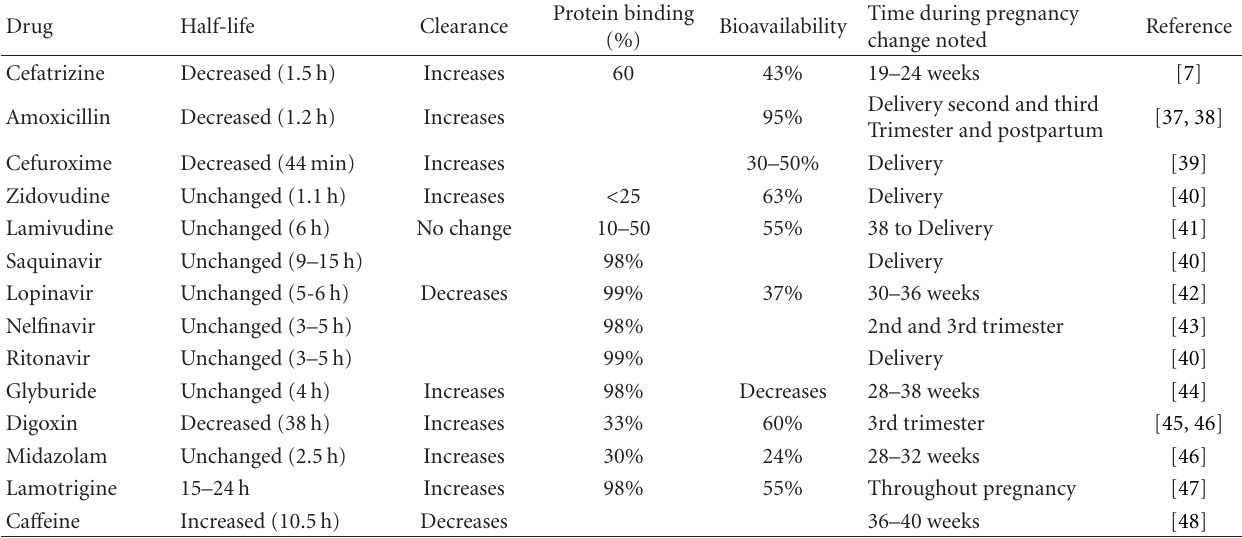
Table 2: Pregnancy-induced pharmacokinetic changes for selected